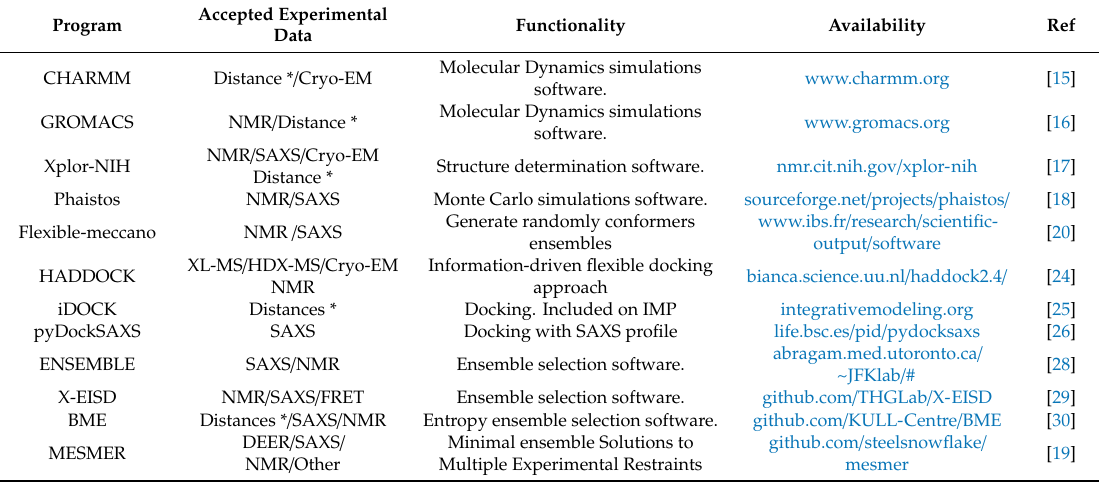
Table 2. List of some of the available software used in the integration of experiments with computational